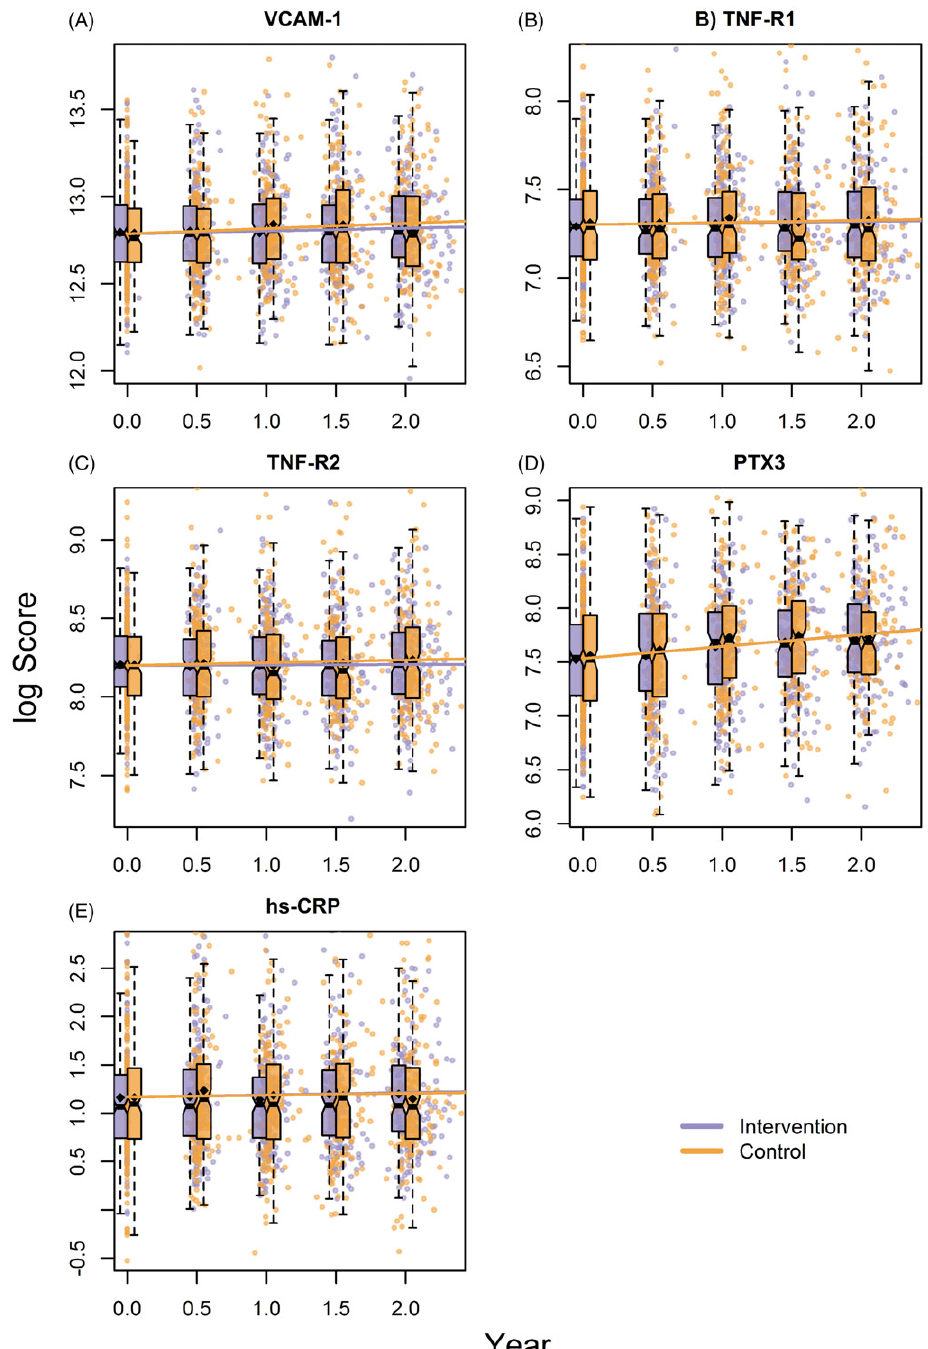
Figure 1. Change over time of the five inflammatory biomarkers by randomized treatment. The change is shown with boxplots and estimated group means (shown as (cid:129) ) together with fitted lines from the crude linear mixed models in Table